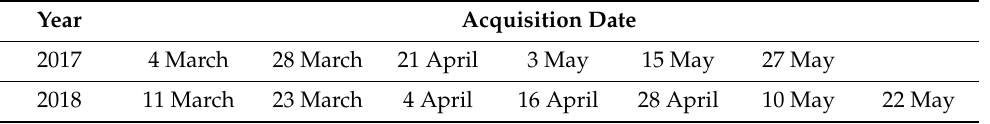
Table 1. Acquisition dates of Sentinel-1 images: Interferometric Wide (IW) swath mode, relative orbit 63, descending. Ground Range Detected (GRD) product type (VV and VH polarization). Images